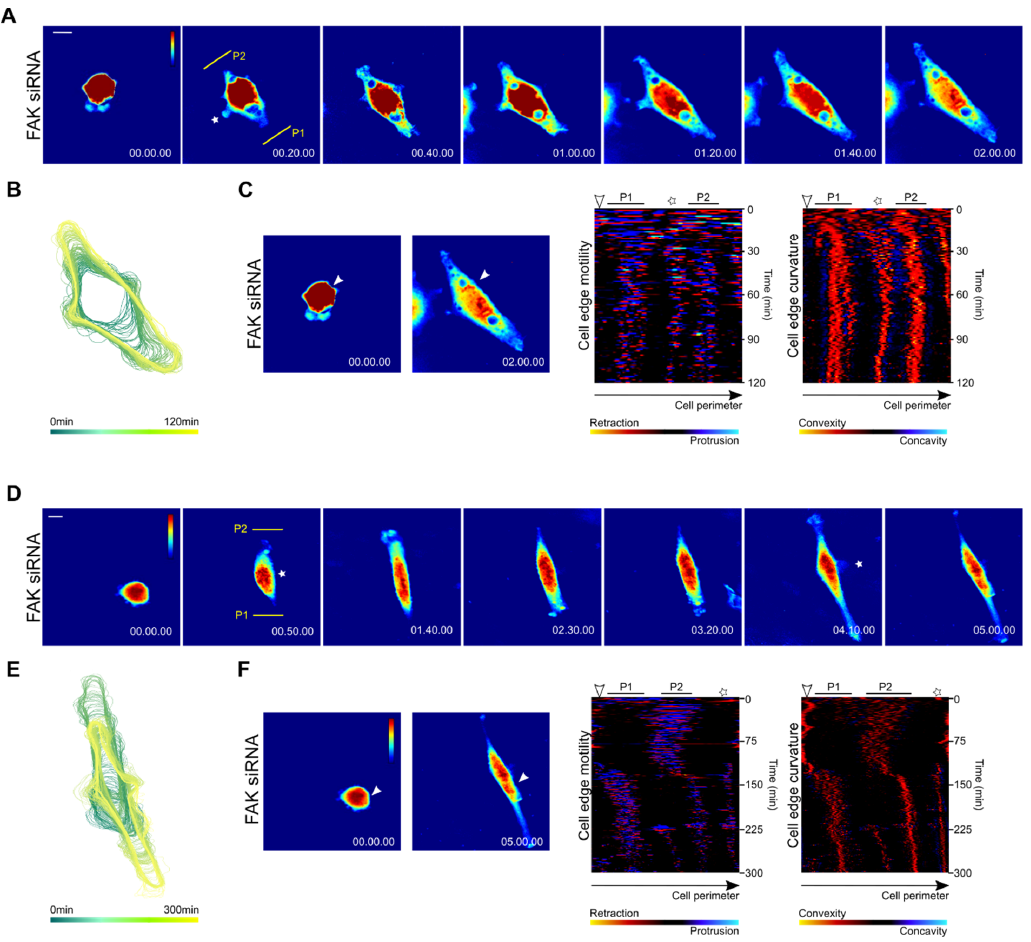
Figure 4. Development of an elongated cell shape in spreading Rat2 fibroblasts depleted of FAK. ( A,D ) Series of pseudo-colored quantitative images selected from time-lapse CCHM showing protruding and retracting areas in two FAK-depleted Rat2 cells spreading on fibronectin. Time is indicated in h.min.s. P1 and P2 indicate protrusive cell poles. ( B,E ) The time sequences of the cell outline during spreading of two FAK-depleted cells superimposed from the first image to the last image. ( C,F ) Cell edge motility and convexity maps of a spreading FAK-depleted cell (see Figure 3C for details). Asterisks indicate a minor protruding region in the nuclear region. Scale bars 10 μm ( A ), 20 μm ( D ).